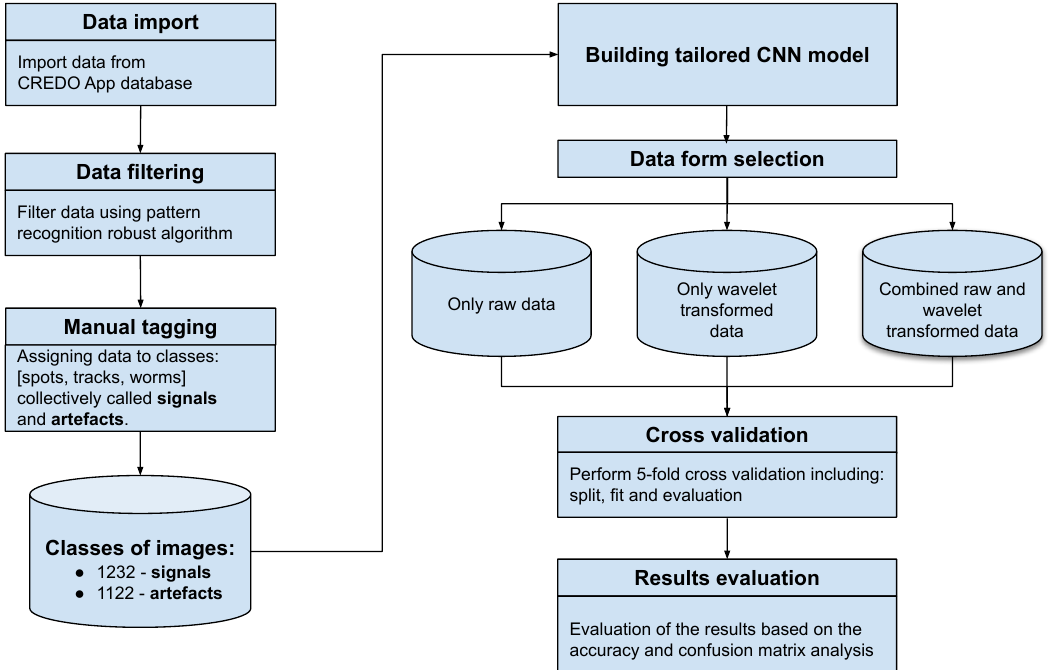
Figure 2. Computation experiment flow